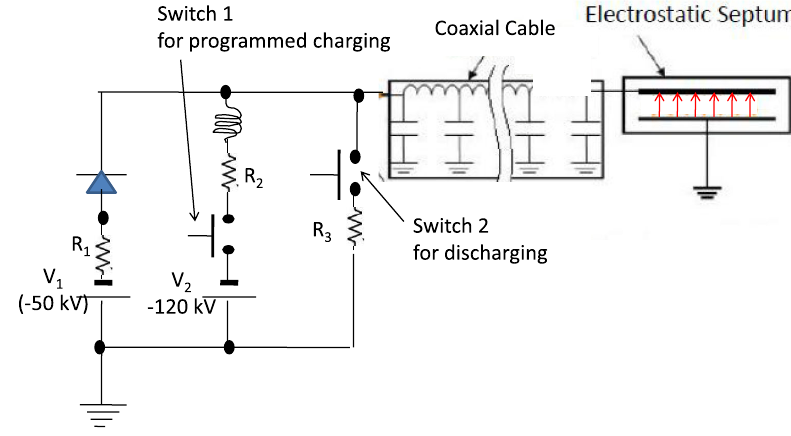
FIG. 16. Equivalent circuit of the electrostatic septum and its high voltage supplies.